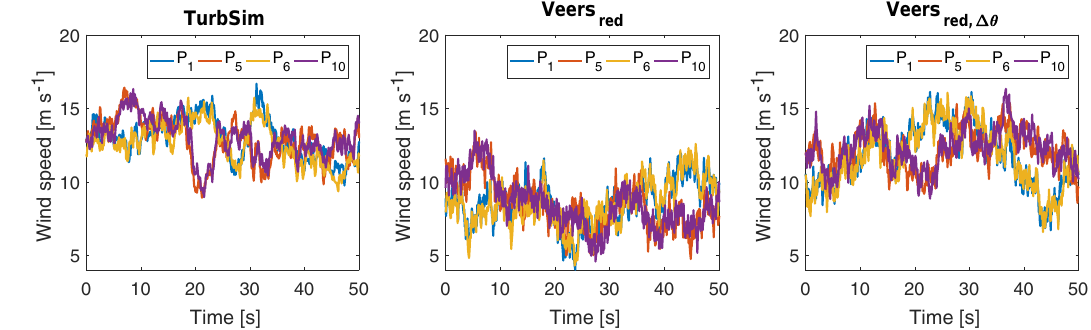
Figure 5. Three 50s excerpts of a wind speed time series samples at four points generated from different models and different random seeds. TurbSim: NREL’s original TurbSim model; Veers red : Veers’ model with a limited number of frequencies ( N F = 20); Veers red ,(cid:49)θ : Veers’ model with a limited number of frequencies and deterministic phase increments. See Table 1 for additional information.